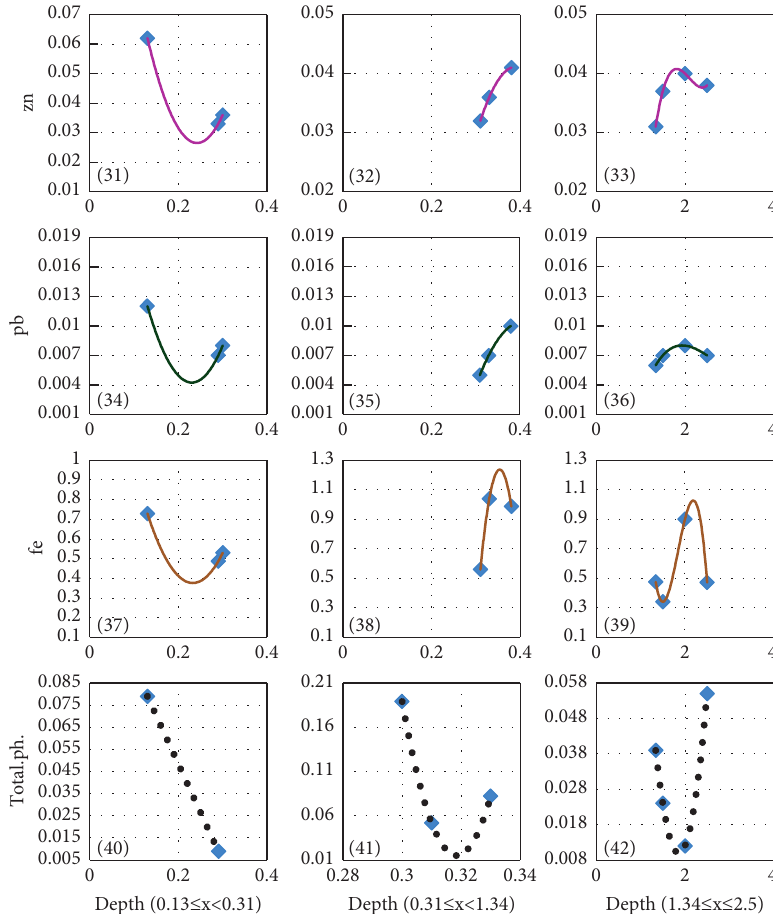
Figure 10: Estimation of the regressions of zn, pb, fe, and total pH in Lake Manzala, Egypt.